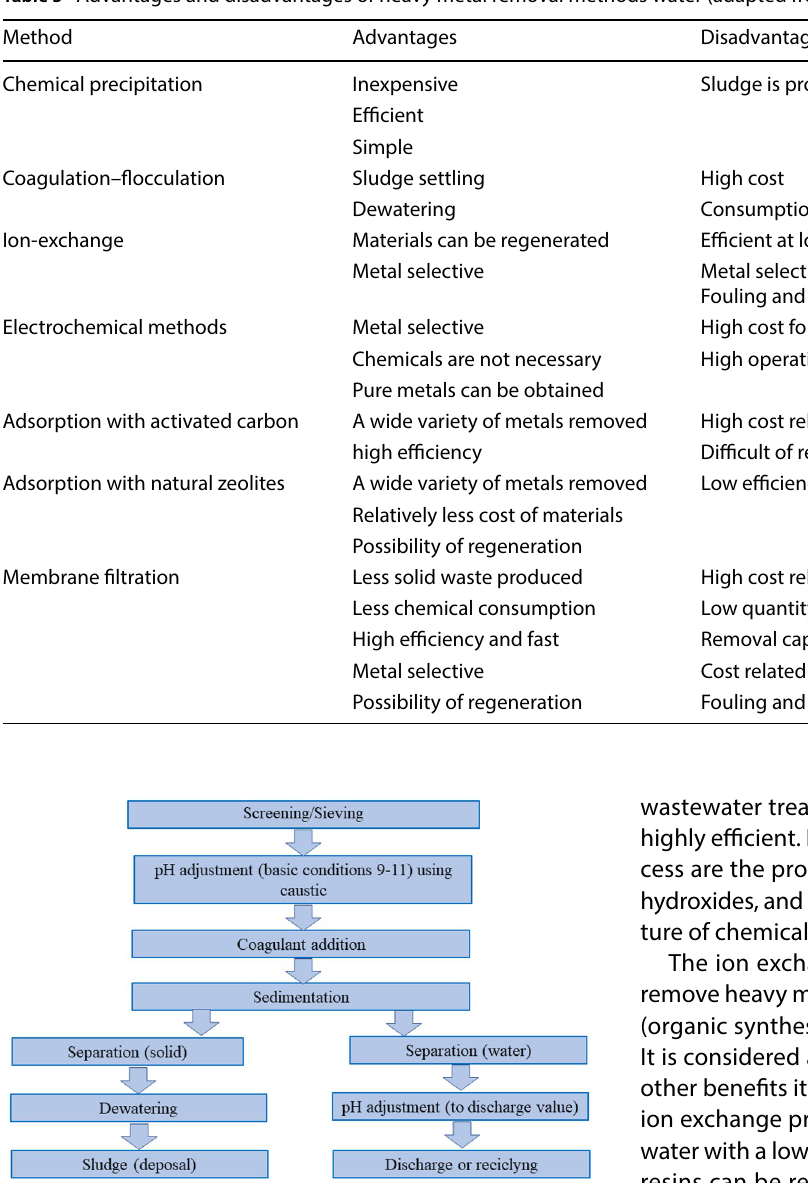
Table 3 Advantages and disadvantages of heavy metal removal methods water (adapted from [29,